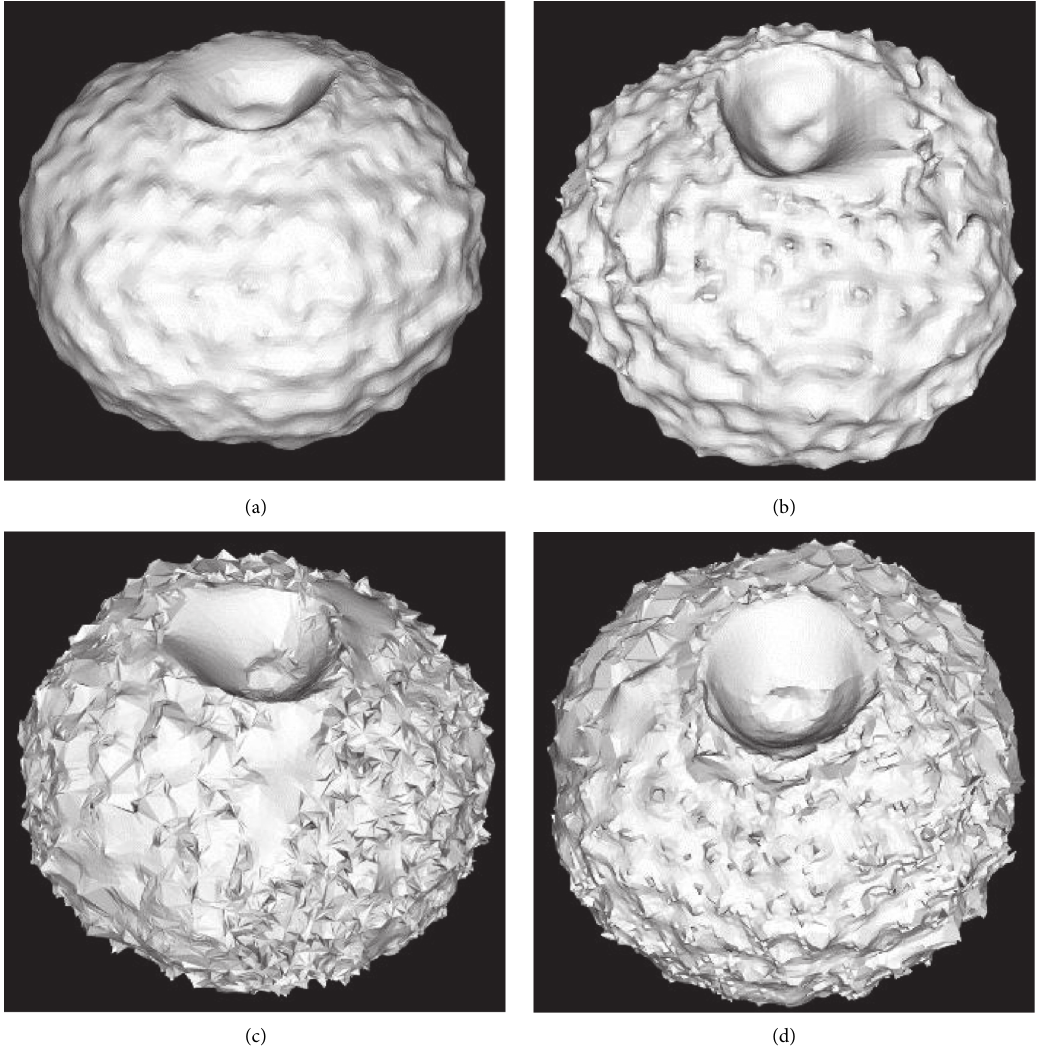
Figure 9: Effect of Rosa roxburghii fruit reconstruction with different reconstruction algorithms. (a) Poisson reconstruction; (b) screened Poisson reconstruction; (c) greedy projection; (d) Delaunay triangulation.